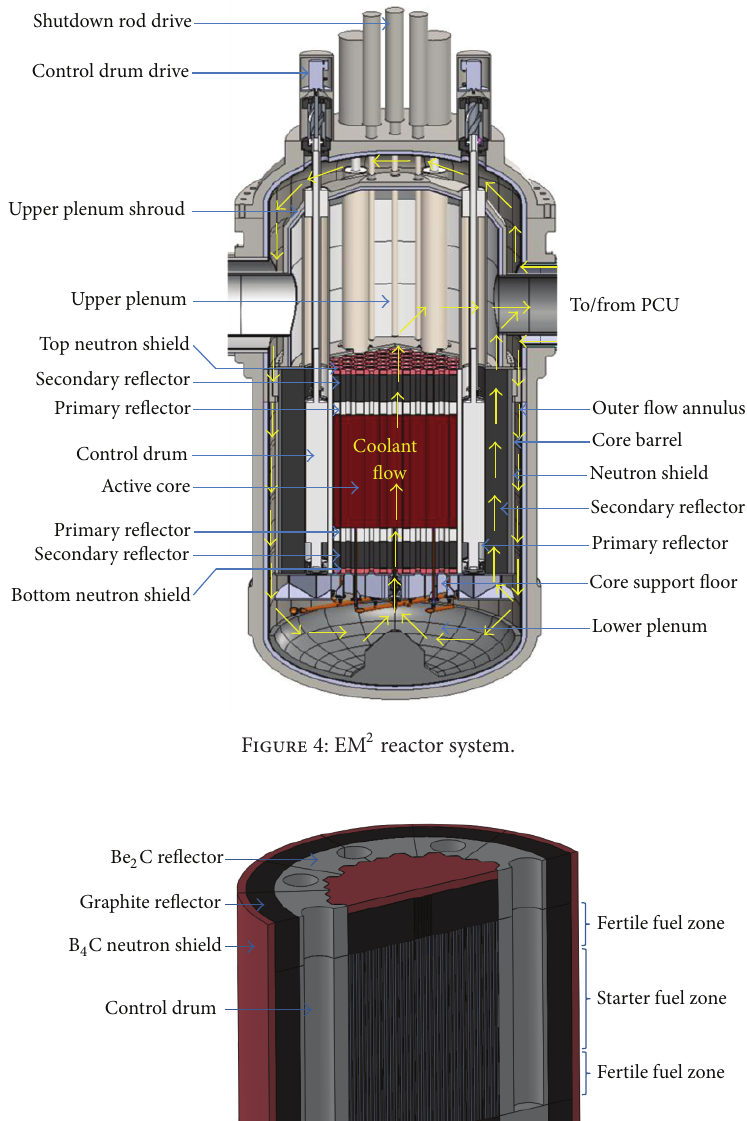
Figure 5: EM 2 baseline core